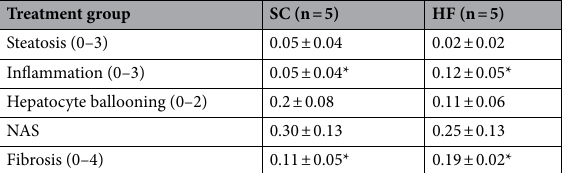
Table 1. Histopathological scoring of liver tissue according to Kleiner et al. 15 . The NAFLD Activity Score (NAS) is the sum of the steatosis, lobular inflammation, and hepatocyte ballooning scores. Values are mean ± SD. Significant differences between groups are indicated by * p < 0.05, Student’s t-test.